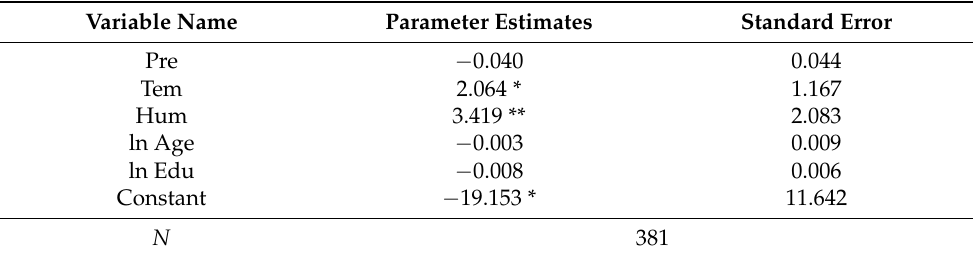
Table 6. Tobit model estimates for the inefficiency influencing